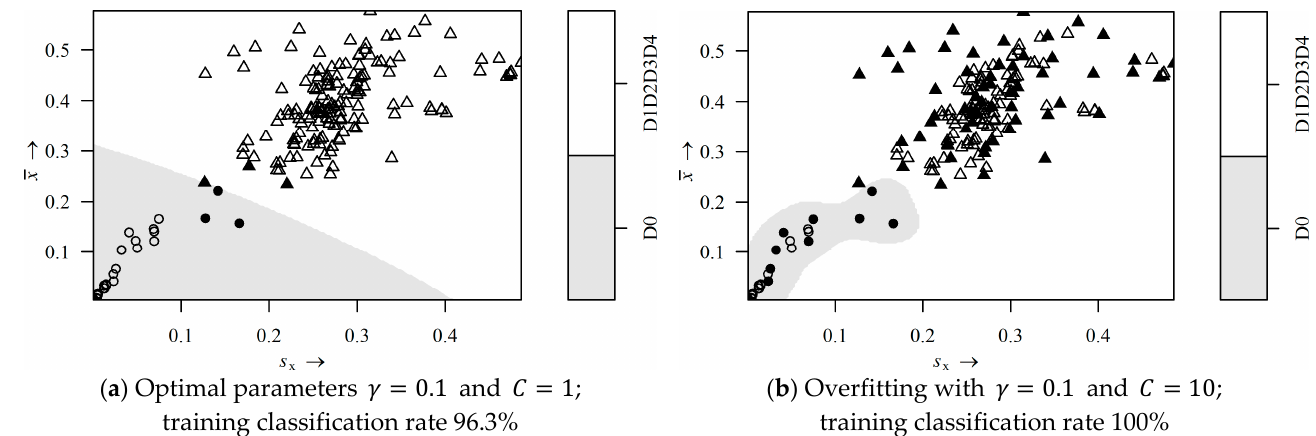
( a ) Optimal parameters 𝛾 = 0.1 and 𝐶 = 1 ; training classification rate 96.3% Figure 9. Training for the classifier SVM-1, with the resulting hyperplane using optimal parameters ( a ), and suboptimal parameters ( b ).